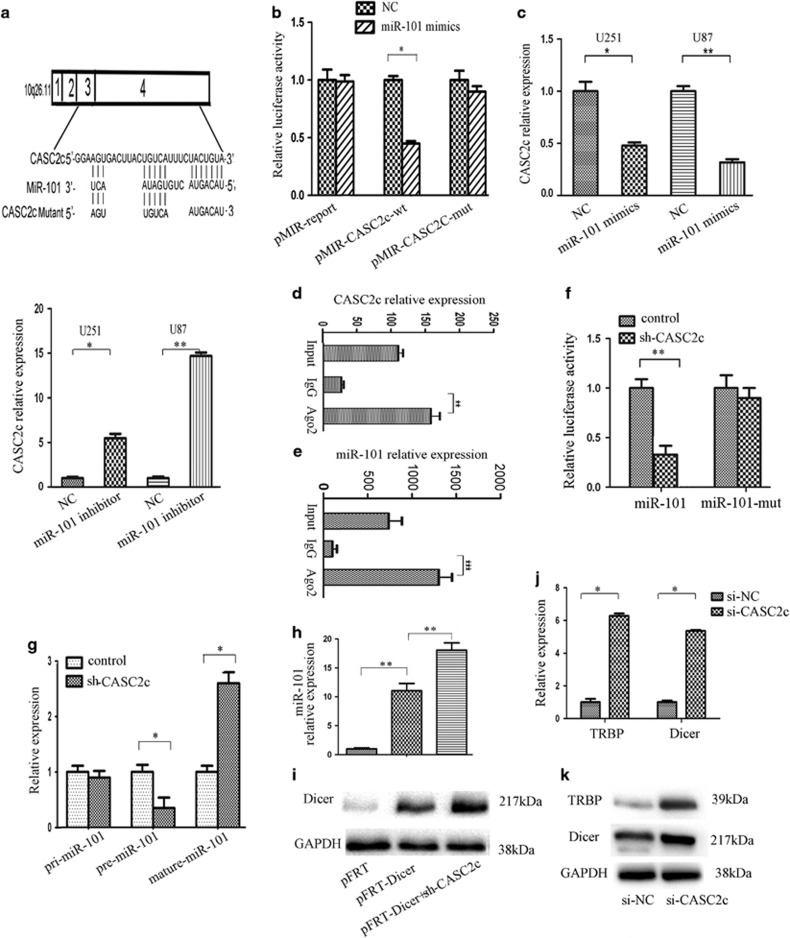
CASC2c and miR-101 existed in RISC complex simultaneously and formed a reciprocal repression loop between miR-101 and CASC2c. (a) Alignment of potential CASC2c base pairing with miR-101 was identified by using DIANA LAB (http://diana.cslab.ece.ntua.gr/microT/). (b) Relative fluorescence activity in U251 cells co-transfected with pMIR-REPORT-WT/mutant CASC2c and miR-101 or the negative control. Data presented as mean±S.E.M. of three independent experiments; *P<0.05. (c) Expression of CASC2c was assayed by real-time qPCR in miR-101 mimics/miR-101 inhibitor-transfected U251 and U87 cells. Data presented as mean±S.E.M. of three independent experiments; *P<0.05, **P<0.01. (d and e) Association of CASC2c and miR-101 with Ago2 in U251 cells. CASC2c and miR-101 expression levels were detected using real-time qPCR. Data presented as mean±S.E.M. of three independent experiments; **P<0.01, ***P<0.001. (f) Relative fluorescence activity in U251 cells co-transfected with the pMIR-miR-101 wild-type reporter plasmid (or the corresponding pMIR-miR-101mutant reporter) and shCASC2c/pcDNA3.1-CASC2c plasmid or the negative control. Data presented as mean±S.E.M. of three independent experiments; **P<0.01. (g) The expression of pri-miR-101, pre-miR-101-1 and mature miR-101 was measured by real-time qPCR in NC- or shCASC2c-transfected U251 cells. Data presented as mean±S.E.M. of three independent experiments; *P<0.05. (h) The expression of miR-101 was analyzed through real-time qPCR in pFRT plasmid, pFRT-Dicer or pFRT-Dicer-transfected U251 cells. Data presented as mean±S.E.M. of three independent experiments; *P<0.05, **P<0.01. (i) The expression of Dicer was measured by western blot in pFRT plasmid, pFRT-Dicer or pFRT-Dicer-transfected U251 cells. (j) The expression of Dicer and TRBP was evaluated using real-time qPCR in control/si-CASC2c-transfected U251 cells. Data presented as mean±S.E.M. of three independent experiments; *P<0.05. (k) The expression of Dicer and TRBP was evaluated using western blot in control/si-CASC2c-transfected U251 cells